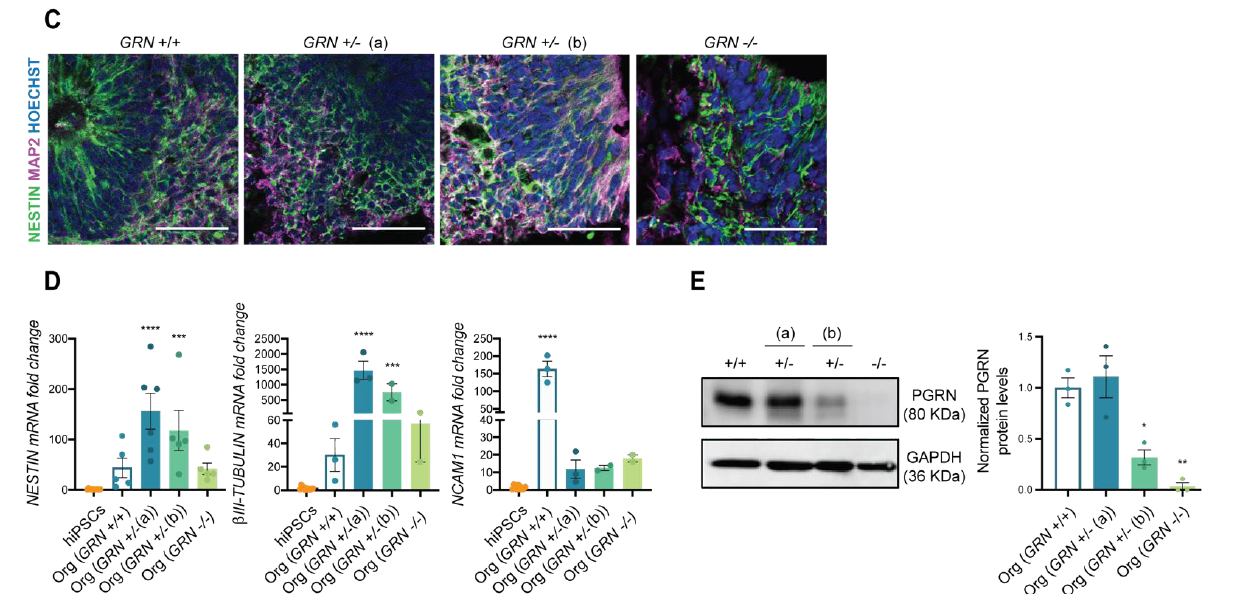
Figure 4. FTLD patient-derived hiPSCs are capable of generating brain organoids. One colony of each newly established hiPSC lines was used to generate human 3D brain models (NCBL1.c5; NCBL2.c46; NCBL3.c6 and NCBL4.c27). ( A ) Schematic representation of the organoid generation,